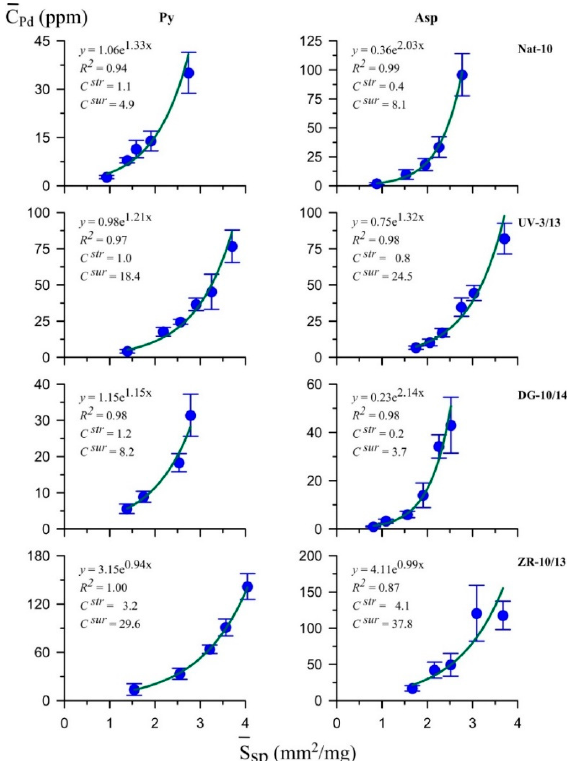
Figure 5. Dependence of the average concentration of evenly distributed Au in pyrite (Py) and arsenopyrite (Asp) on the specific surface area of an average crystal in size fraction. The expressions for approximate curves and concentrations of structurally and superficially bound modes are shown (see Table S1 in the Supplementary Materials for details).